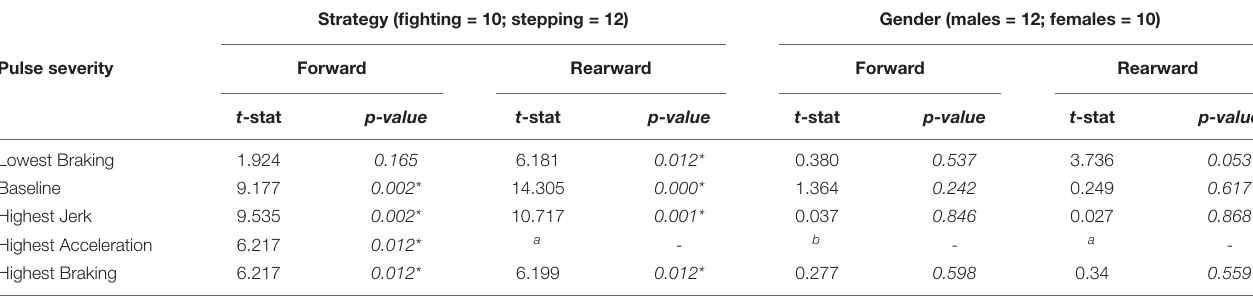
TABLE 6 | Statistical results based on recovery strategy and gender. Strategy (fighting = 10; stepping = 12) Gender (males = 12; females =